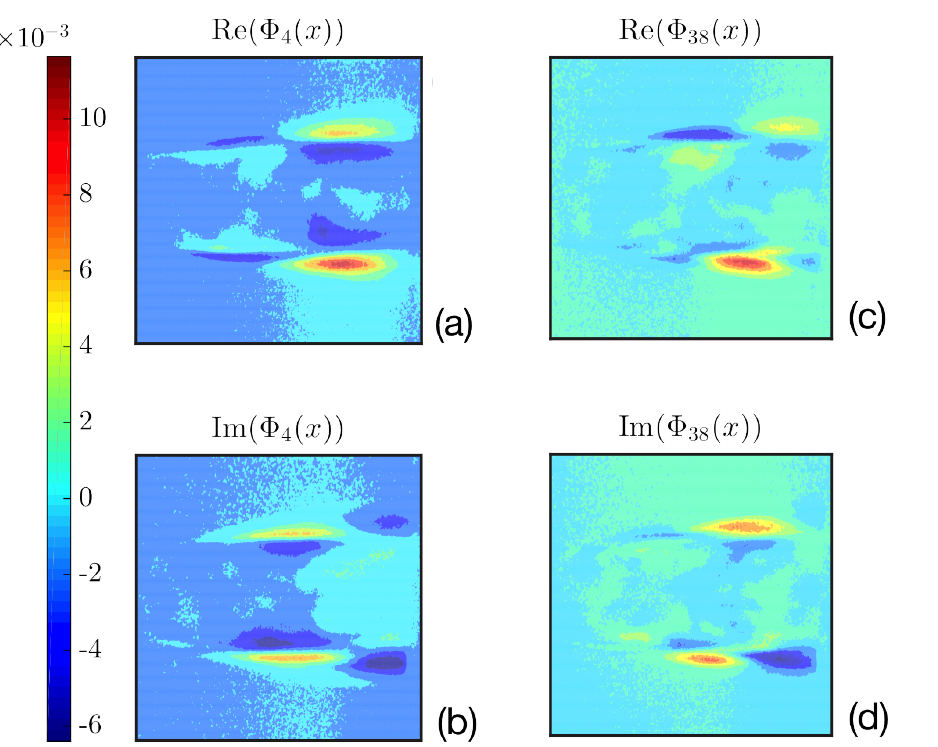
Figure 4. ( a ) Real and ( b ) imaginary parts of Φ 4 ( x ) , the symmetric mode with the largest energy, for the reacting flow at φ = 0.8. ( c ) Real and ( d ) imaginary parts of Φ 38 ( x ) , the asymmetric mode with the highest energy. This figure was adapted from the Ref. [31].